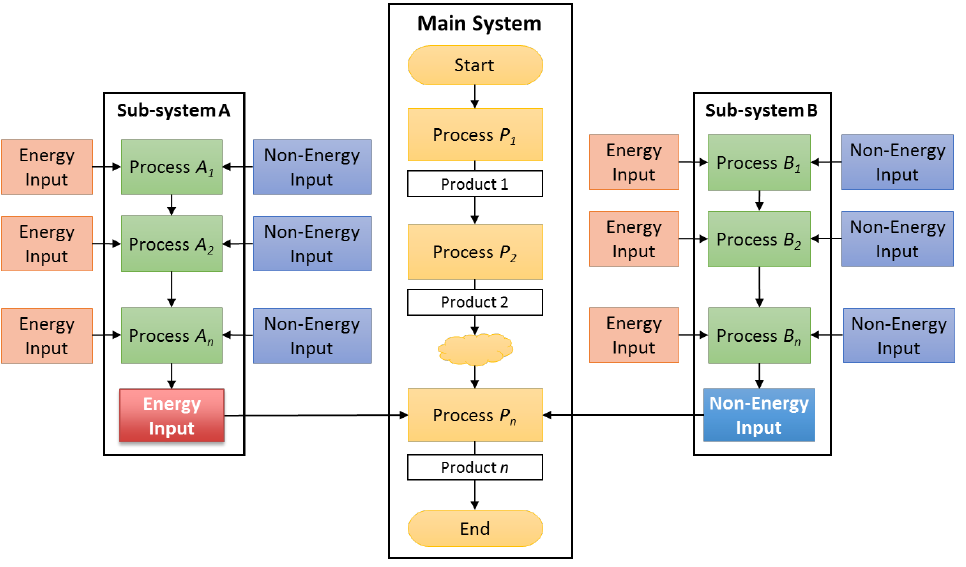
Figure 3. Boundaries between the life cycle Main System and the Sub-systems.